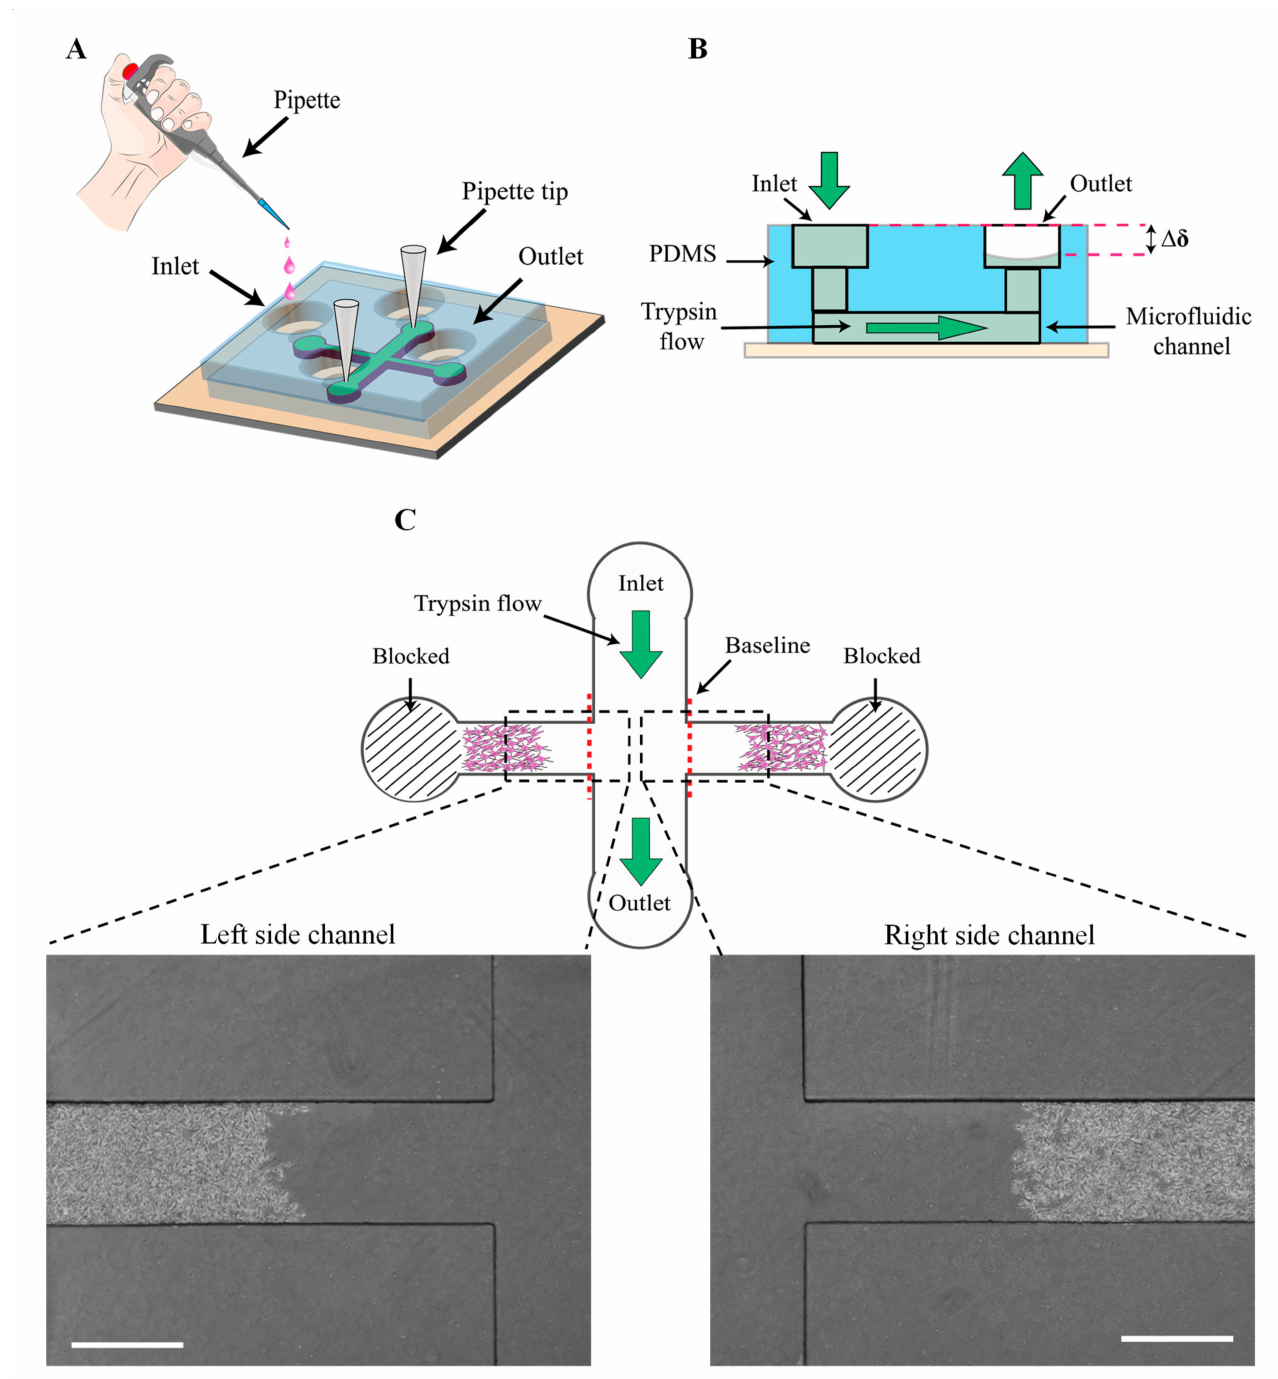
Figure 3. Process of cell-free generation. ( A ) Experiment setup. While the terminals of the side channels were blocked, trypsin was added to the inlet. ( B ) Side view and ( C ) top view, gravity as a driving force was used to flow the trypsin from the inlet to the outlet to generate the cell-free area in the main